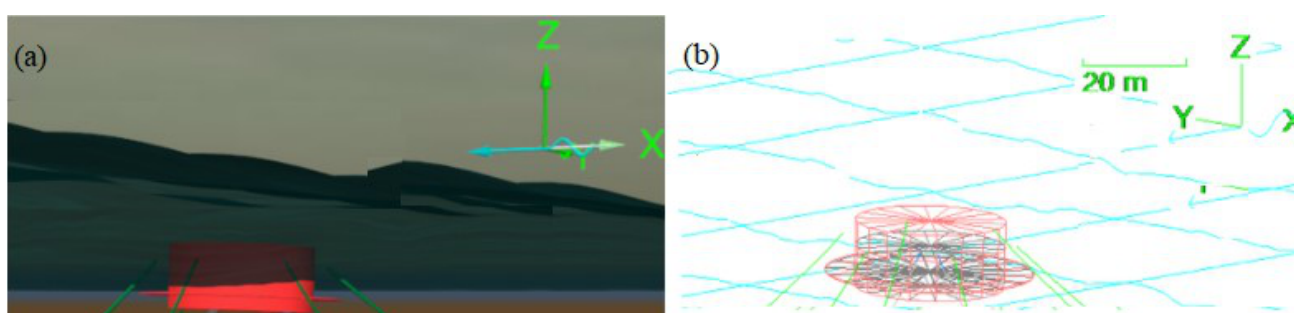
Figure 5. CALM Buoy Model showing ( a ) shaded view, and ( b ) wireframe view, modelled in Orcaflex 11 .